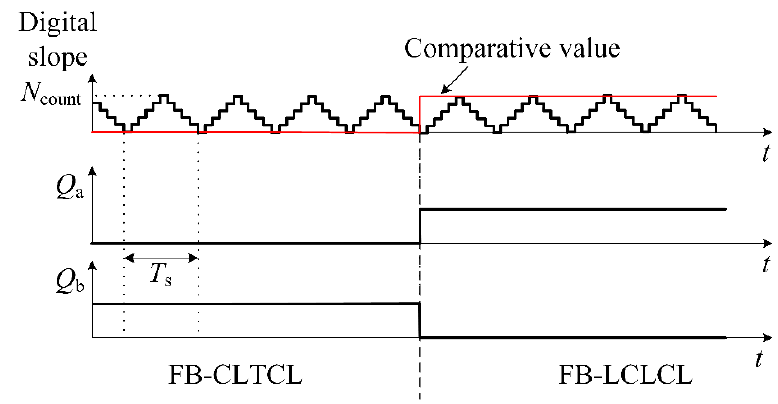
Figure 8. Adjustment of duty ratio for Q a and Q b with traditional control method during transient switching process a.